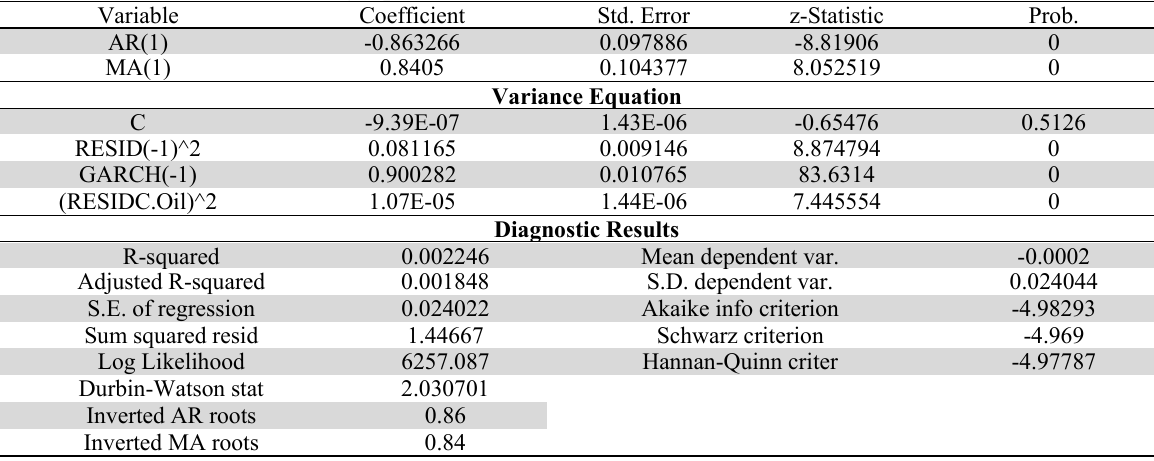
Univariate GARCH – Volatility Spillover Effect (S&P500 index to Crude oil)